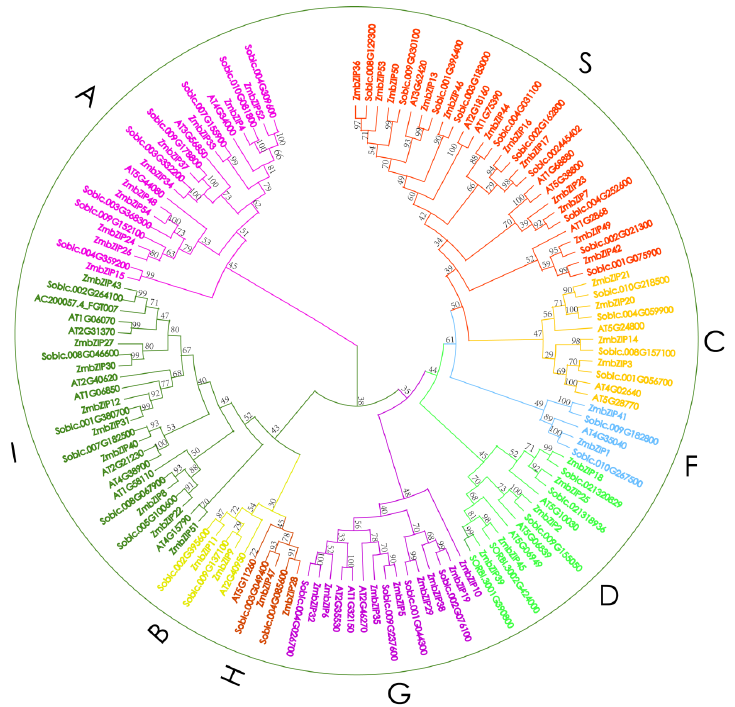
Figure 1. Complex phylogenetic tree of bZIP genes in Arabidopsis , sorghum, and maize. An unrooted tree is generated with the MEGA5.2 software using the amino acid sequences of the bZIP proteins by the neighbor-joining (NJ) method, with 1000 bootstrap replicates. The tree shows nine major phylogenetic groups (group A to S), indicated with different colored backgrounds.